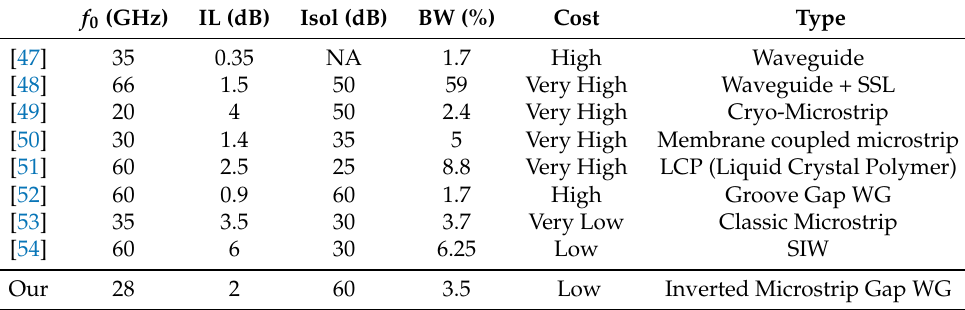
Table 2. Comparison with other mm-Wave measured